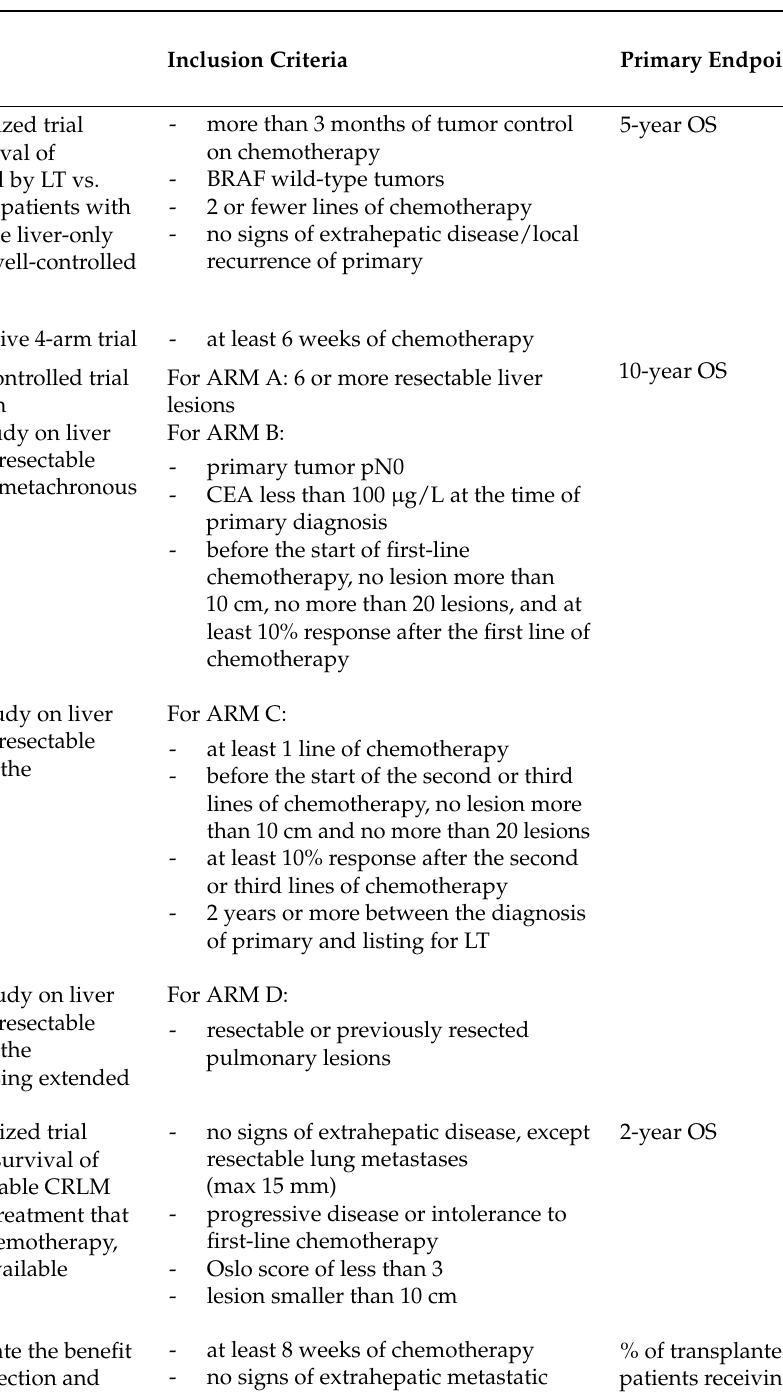
Table 1. Ongoing trials on liver transplantation for colorectal liver metastases